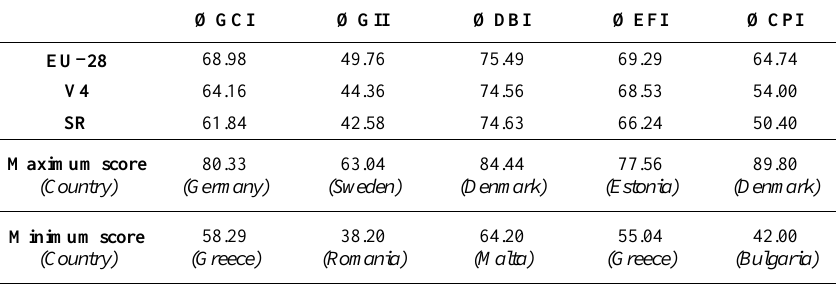
Table 2. Average values analysis (out) of the analysed indices Ø GCI